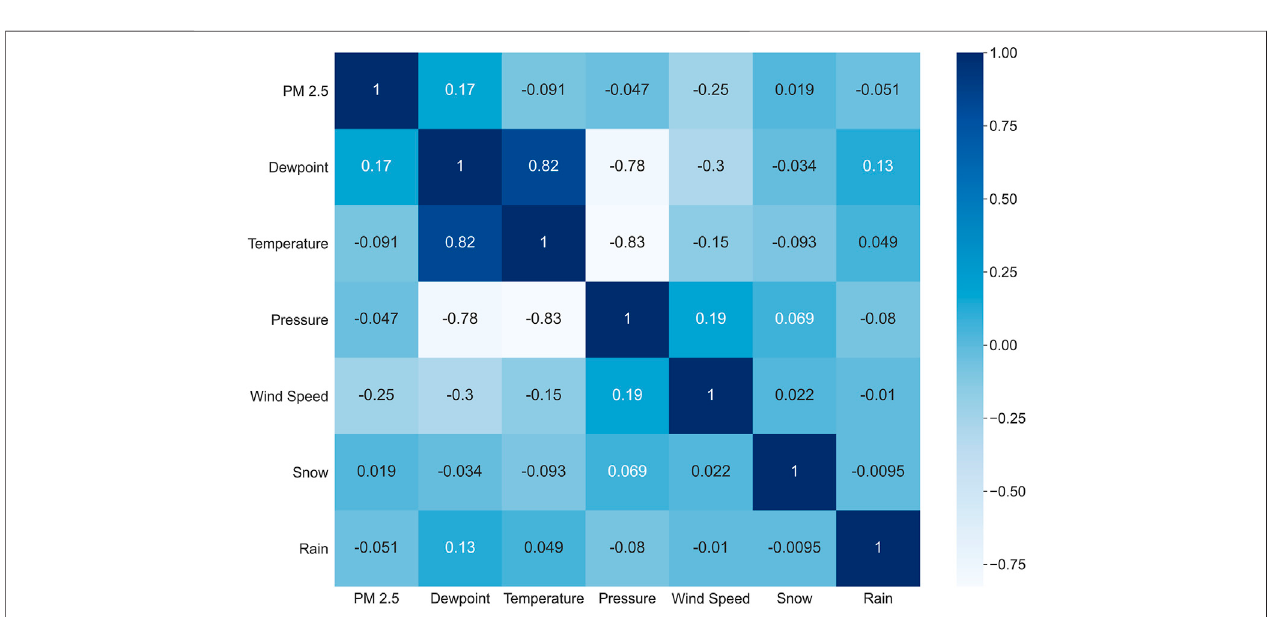
FIGURE 1 | Heatmap of the Pearson ’ s correlation coef fi cient values for different parameters in data. A gradient from dark blue to white color represents strong positive to strong negative correlations,